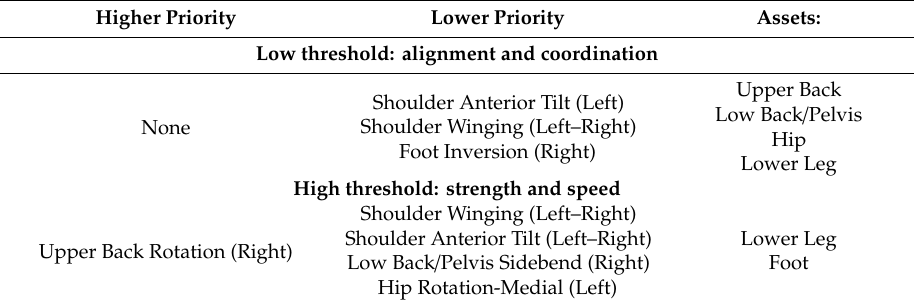
Table A2. The Foundation Matrix report detailing the site direction and threshold of the individual’s movement control impairments post-intervention week